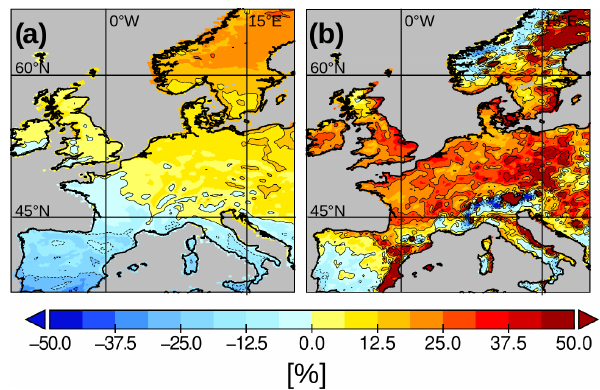
Figure 9. Relative change (difference between 2070–2099 and 1970–1999) in (a) the average precipitation rates and (b) the AR-induced precipitation rates for RCP8.5. Shown are ensemble mean differences.